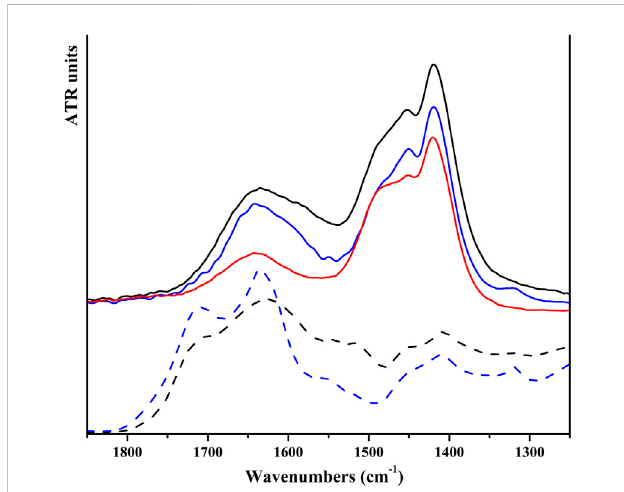
FIGURE 3 FT-ATRspectraofHPNPs(solidredline),solidHAs(blackdashline), solid FAs (blue dash line), and HP NPs coated with HAs (solid black line) and FAs (solid blue line) in the spectral range of 1,250 – 1,850 cm ⁻ 1